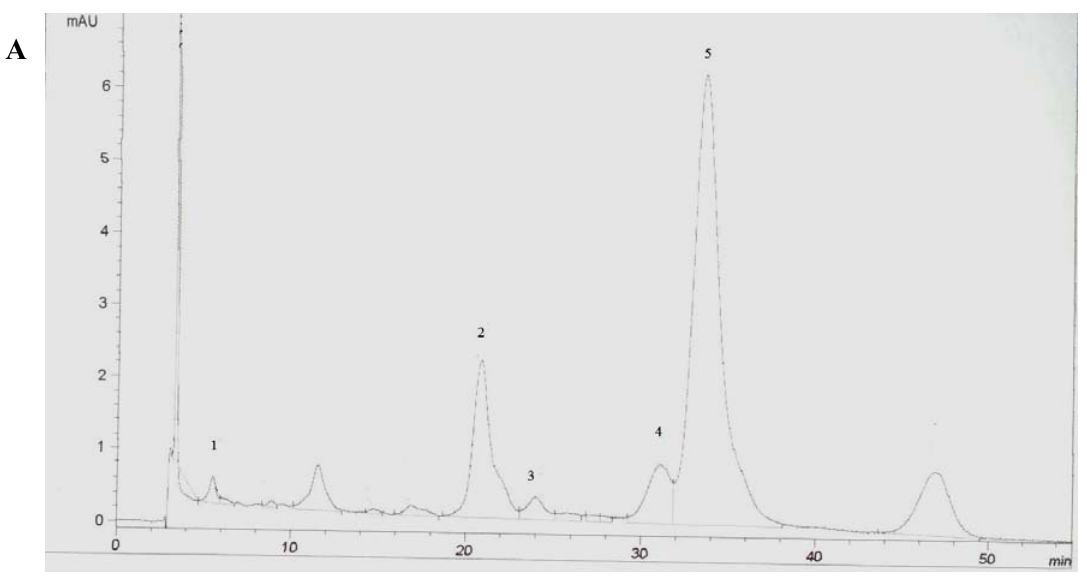
Figure 7. HPLC chromatograms of ( A ) Soxhlet extract; ( B ) supercritical fluid extraction extract (conditions: 60 °C, 300 bar, 0.36 mm and 1.44 cm/min). 1-lutein, 2-all- E